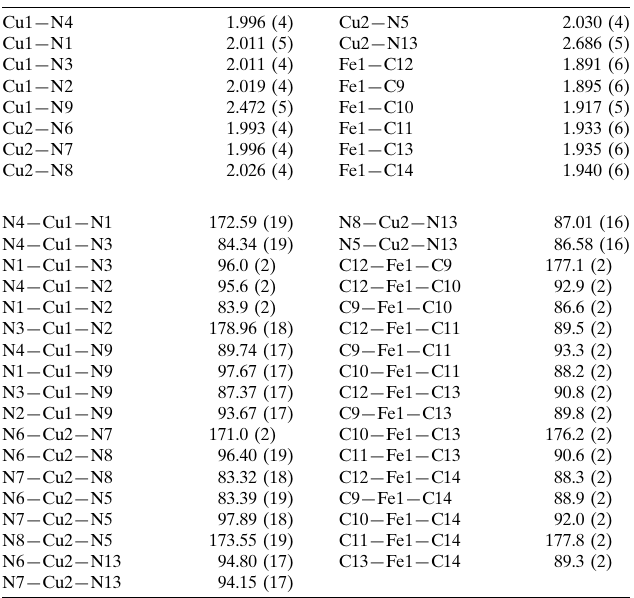
Selected geometric parameters (A˚ , (cid:3)